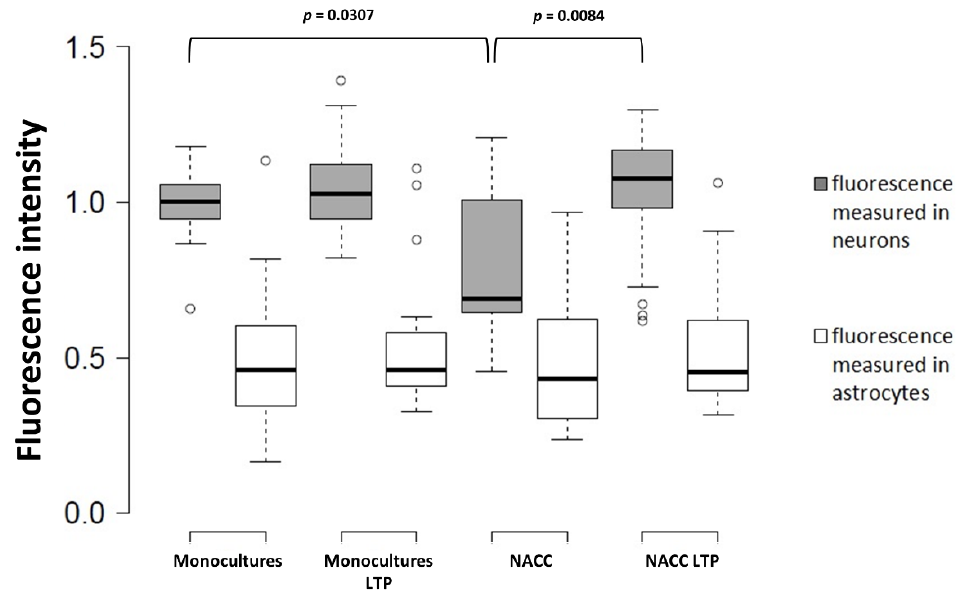
Figure 2. Quantification of the changes in the Fbp2 mRNA level in neuron–astrocyte co-culture under control conditions and after induction of long-term potentiation (LTP). NACC—neuron–astrocyte co-culture, control conditions; NACC LTP—neuron–astrocyte co-culture after induction of LTP. Fluorescence intensity was normalized to control group. The experiment was repeated in